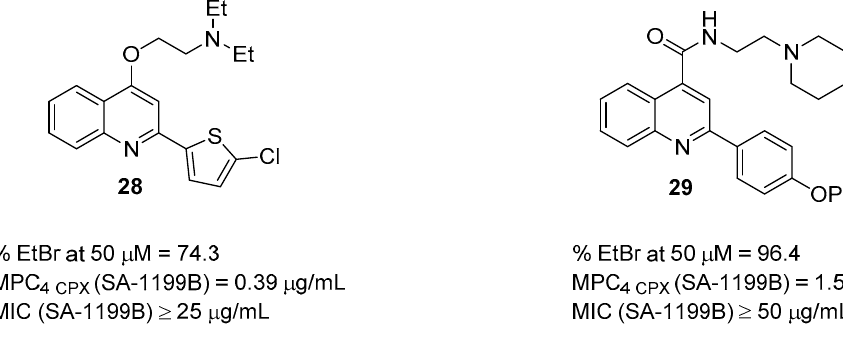
Figure 9. C-2 chlorothiophene-quinoline 28 and C-4 carboxy-quinoline 29 as NorA EPIs.